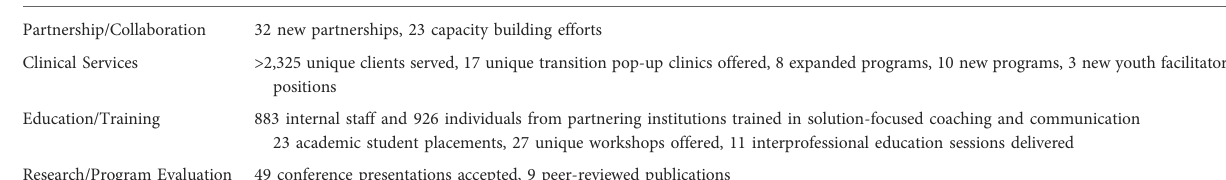
TABLE 1 Summary of key outputs from activities of the Transitions Strategy a .